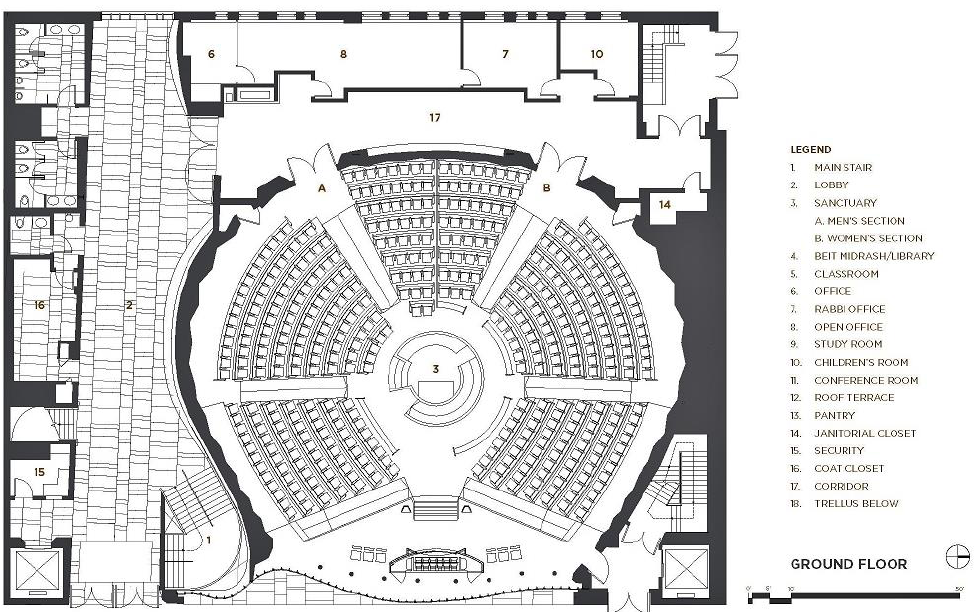
Figure 11. Plan of the ground floor. North is on the right. Courtesy CetraRuddy.